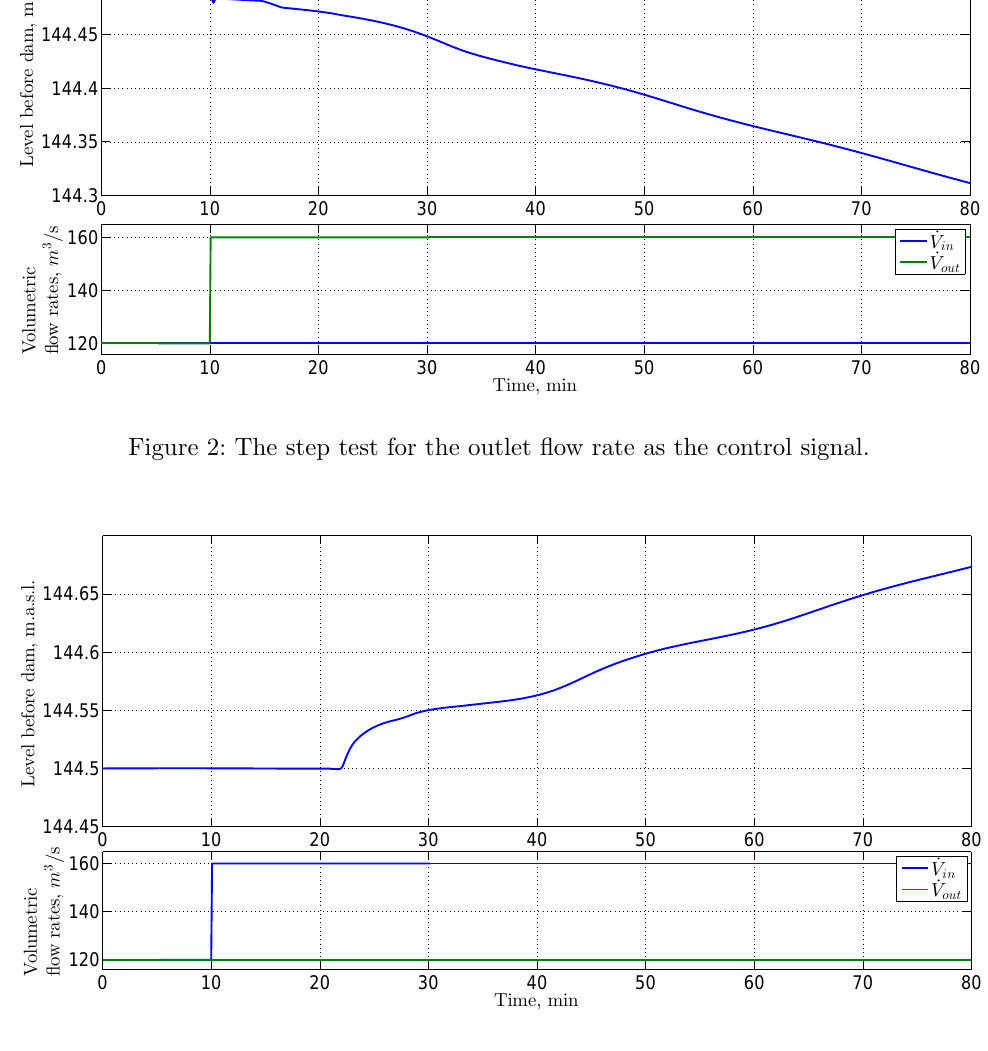
Figure 3: The step test for the inlet flow rate as the control